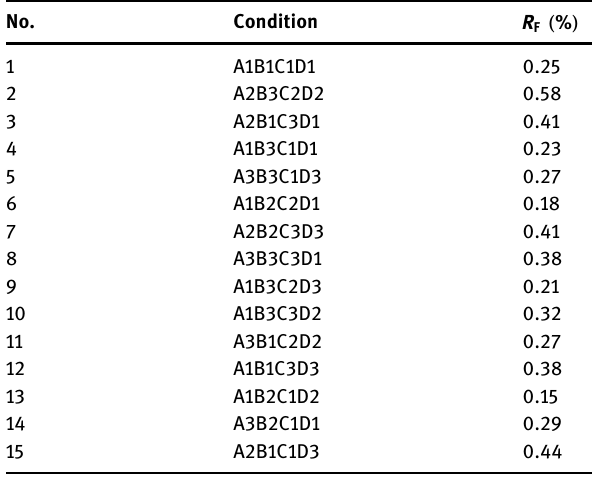
Table 3: R F of samples with di ff erent conditions